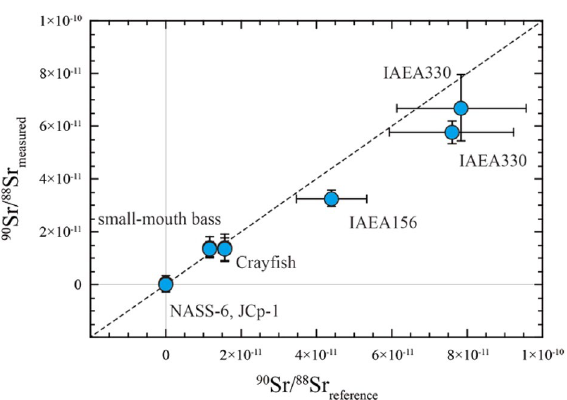
Figure 3. The measured 90 Sr/ 88 Sr ratio of the environmental and biological samples was compared with the decay corrected reference 90 Sr/ 88 Sr ratios. The blue circle represents an average of multiple measurements of the sample. Error bars correspond to 2